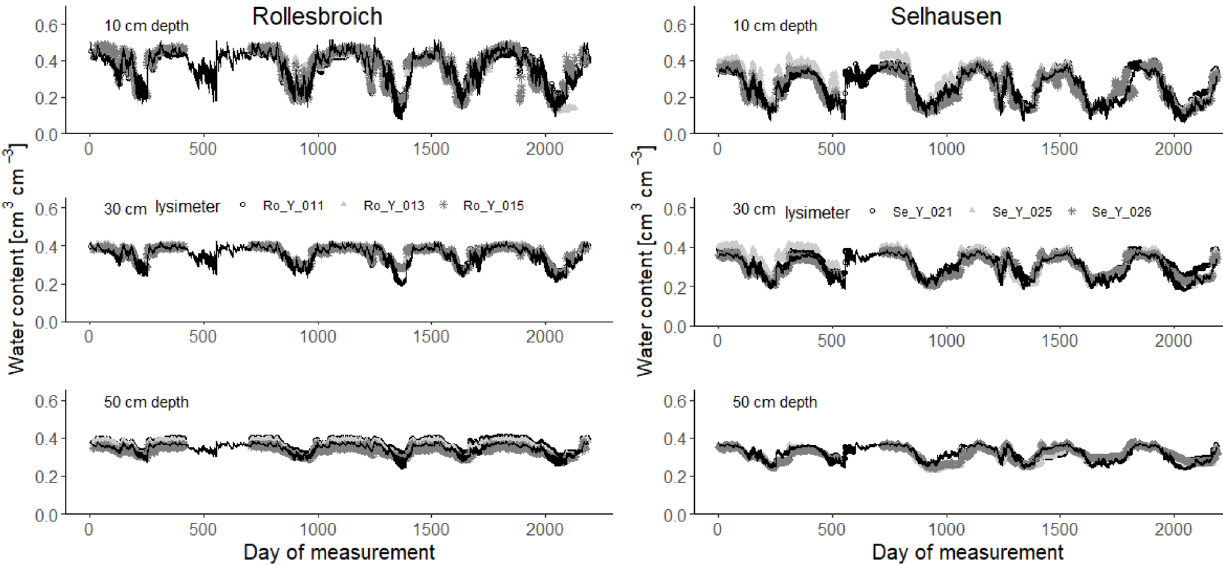
Figure 4. Measured soil water contents (symbols) at 10, 30 and 50cm depth (2013–2018) compared with simulations for the 30 acceptable parameterizations at each site (black lines). Day 1 is 1 January 2013.